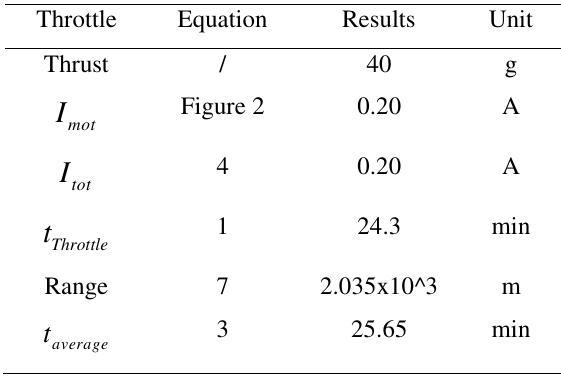
Table 3: Results for NAV in Hover